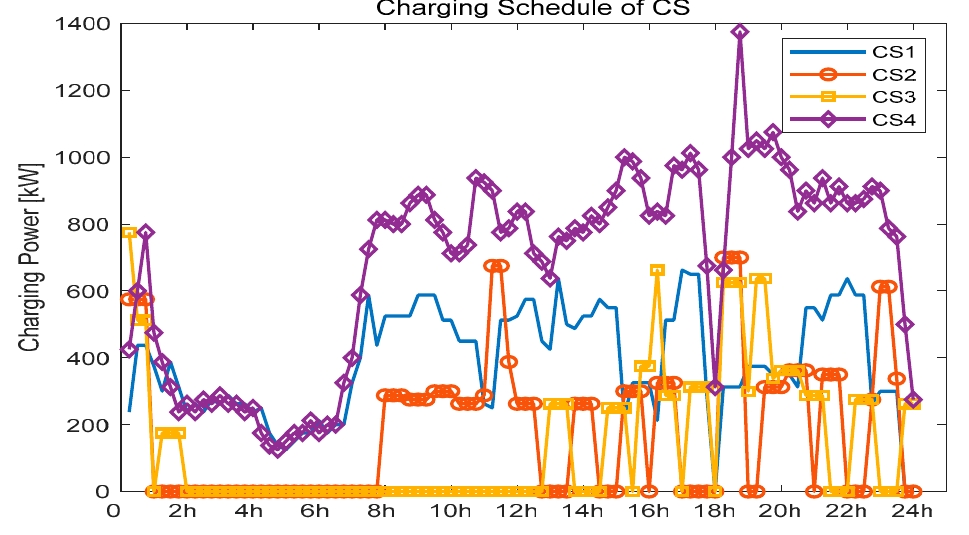
Figure 16. Charging schedule of CSs in Case 4.